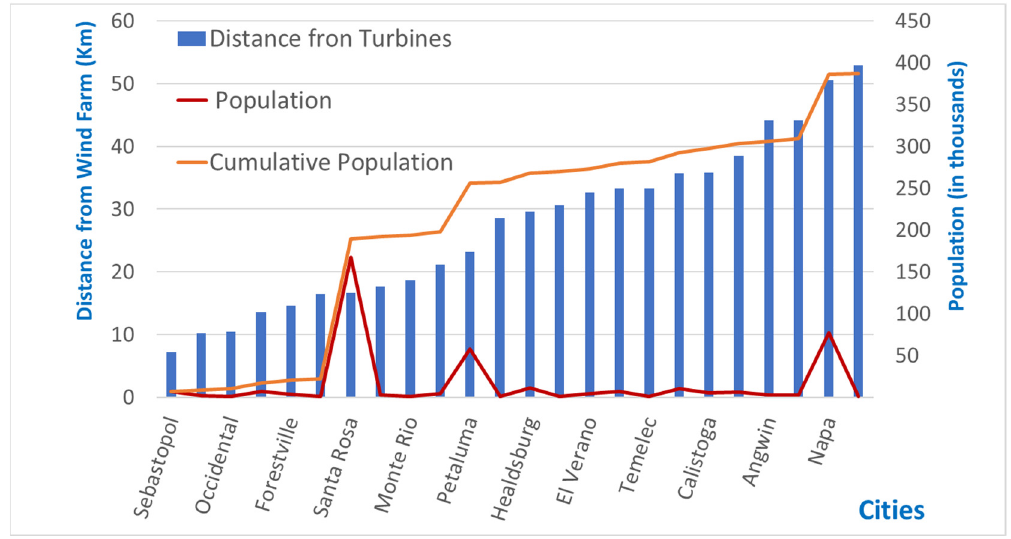
Figure 11. Analysis of distance and population for proposed new wind turbine north of San Francisco area.